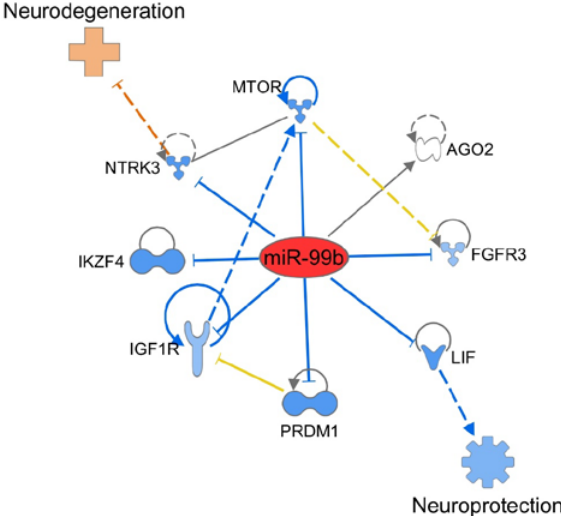
Figure 6. IPA-based schematic representation of the mediators and pathways affected by miR-99b, leading to neuroprotection versus neurodegeneration depending on the direction of change. The description of lines, arrows, color, etc. is same as in the legend to Figure 5.